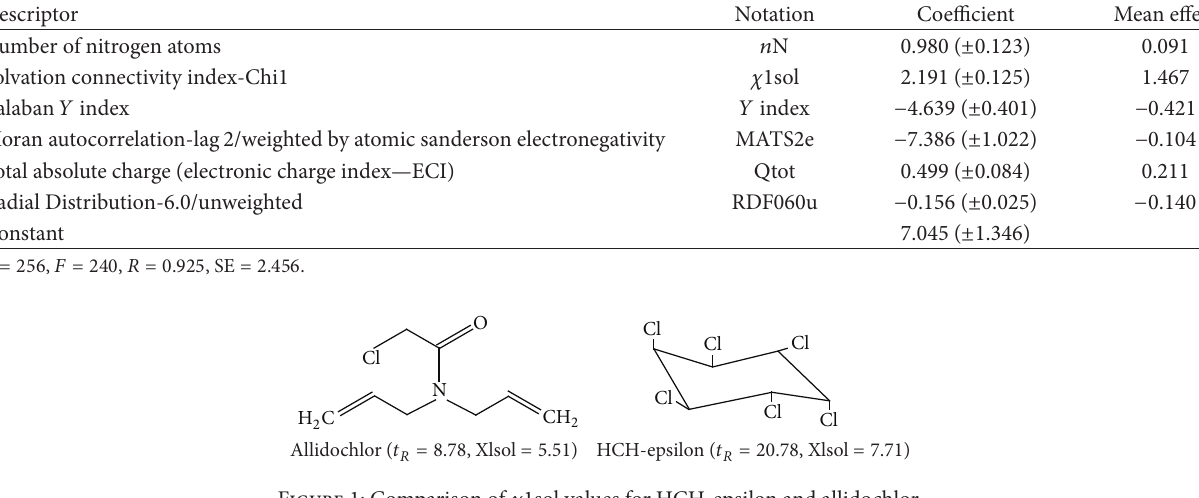
1sol values for HCH-epsilon and 𝜒𝜒